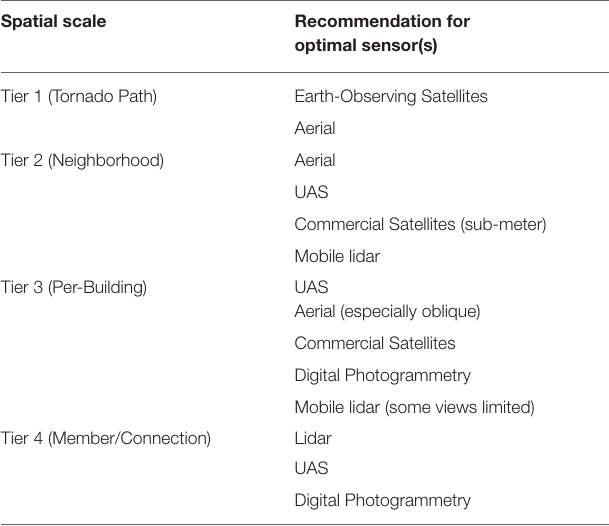
TABLE 1 | Recommended optimal use of sensors by spatial